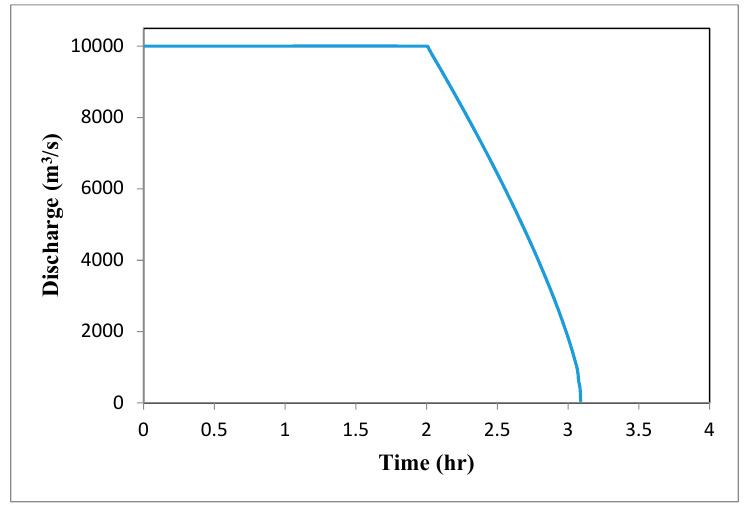
Figure 8. San Giuliano dam-break outflow hydrograph according to the approach that used the 2D propagation model of [41]. Table 1. Summary of the numerical modelling setup for the San Giuliano case study by Sole et al. [37], by the two-dimensional (2D) numerical model of Cantisani et al. [40] and by the proposed GIS tool.